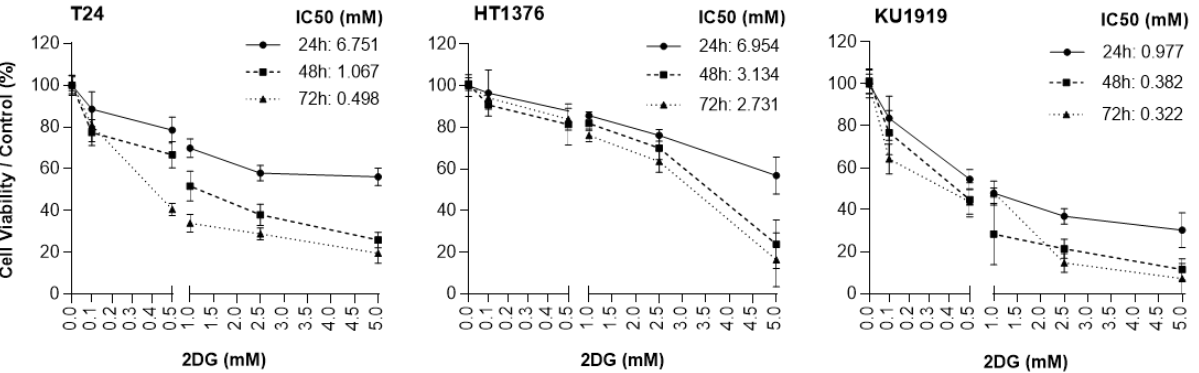
Figure 5. Effect of 2DG on the viability of T24, HT1376, and KU1919 urothelial bladder carcinoma cell lines, detected by the sulforhodamine B assay at 24, 48, and 72 h post-treatment. Dose response curves and IC 50 values are shown. Results are expressed as normalized means ± SD of at least 3 independent experiments, each one in triplicate. The equation for IC 50 determination is Y = Bottom + (Top − Bottom)/(1 + 10 ((LogIC50-X)*HillSlope)) . p values are considered non-significant for HT1376 24 h 0 mM vs. 0.1 mM and 0 mM vs. 0.5 mM; p < 0.01 for T24 24 h 0 mM vs. 0.1 mM; p < 0.005 for HT1376 24 h 0 mM vs. 1.0 mM, HT1376 48 h 0 mM vs. 0.1 mM, and KU1919 24 h 0 mM vs. 0.1 mM; and p < 0.001 for the remaining 2DG concentrations and exposure times.